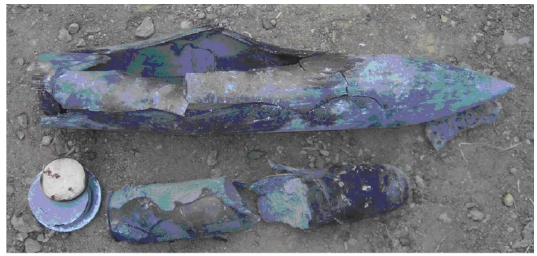
Figure 2. Penetration experiment results.